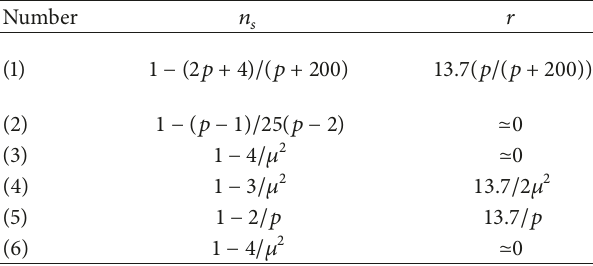
Table 3: Inflationary parameters for each